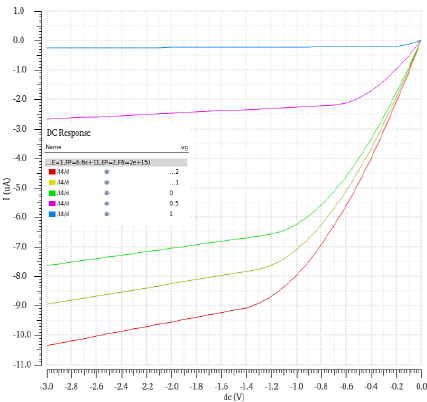
Fig. 4. Dependence I D (V D ) when combined with the fluxes of neutrons, electrons and protons